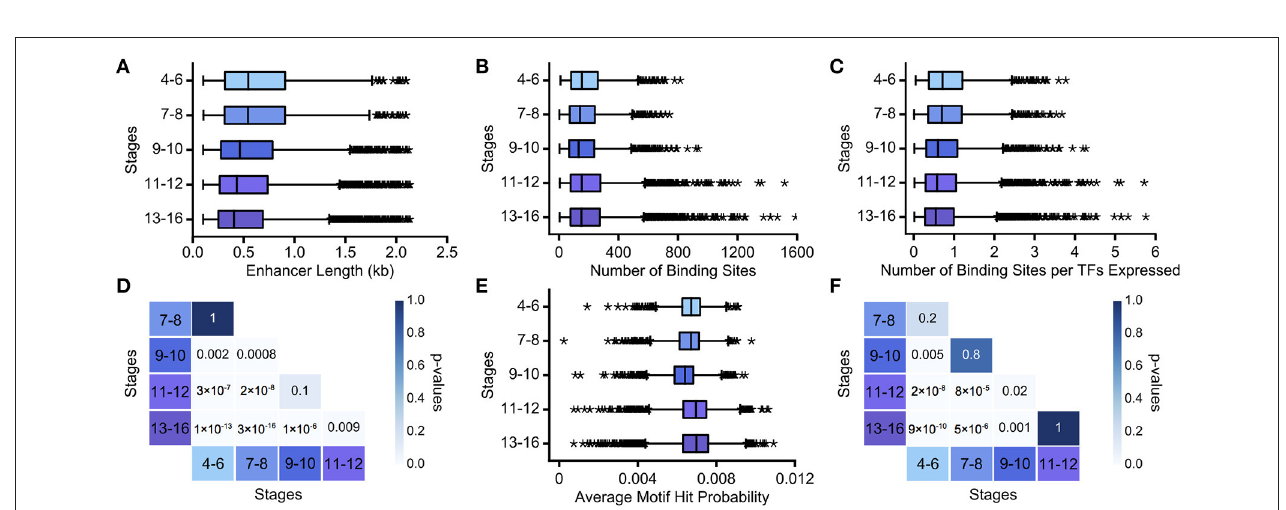
FIGURE 3 | Decreasing regulatory task complexity over embryogenesis is associated with decreasing enhancer length. We show boxplots of (A) the length of minimal Vienna Tile enhancers, (B) the number of TF binding sites predicted in minimal Vienna Tile enhancers, (C) the number of TF binding sites predicted in minimal Vienna Tile enhancers normalized by TFs concurrently expressed, and (E) the average motif hit probability of minimal Vienna Tile enhancers over developmental stages 4–16. The heatmaps display the Bonferroni-adjusted p -values from the Mann-Whitney rank test between (D) pairwise distributions of Vienna Tile enhancer length and between (F) pairwise distributions of the number of TF binding sites predicted in Vienna Tile enhancers per TFs concurrently expressed. In all box plots, the boxes indicate the lower and upper quartiles, with the line within the box indicating the median. Whiskers extend to 1.5*IQR plus or minus the upper and lower quartile, respectively, and the stars indicate outliers that fall outside the